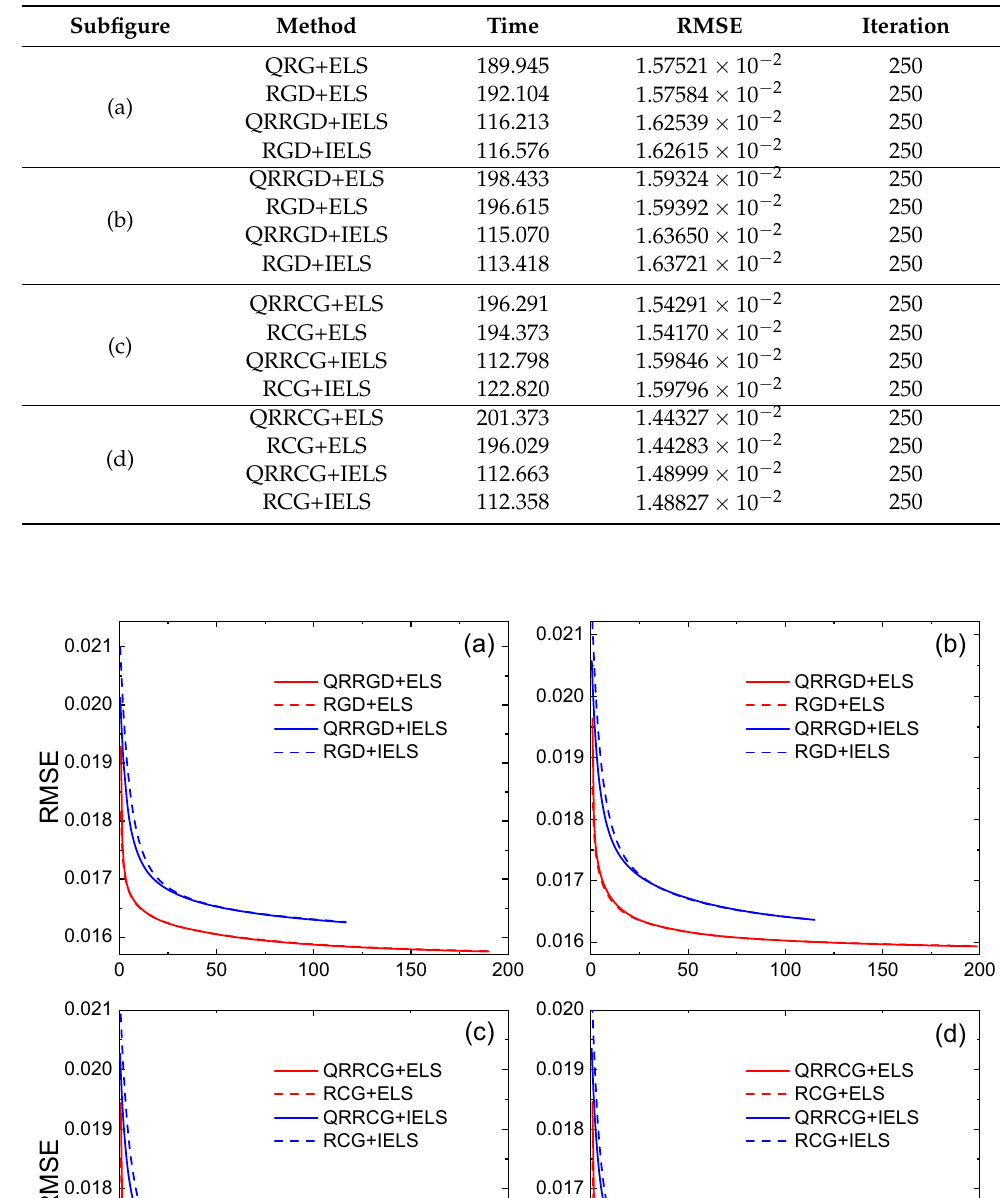
Table 6. Computational results for Figure 6 on PeMS Traffic. The time is rounded to three decimal places and RMSE is rounded to five decimal places.